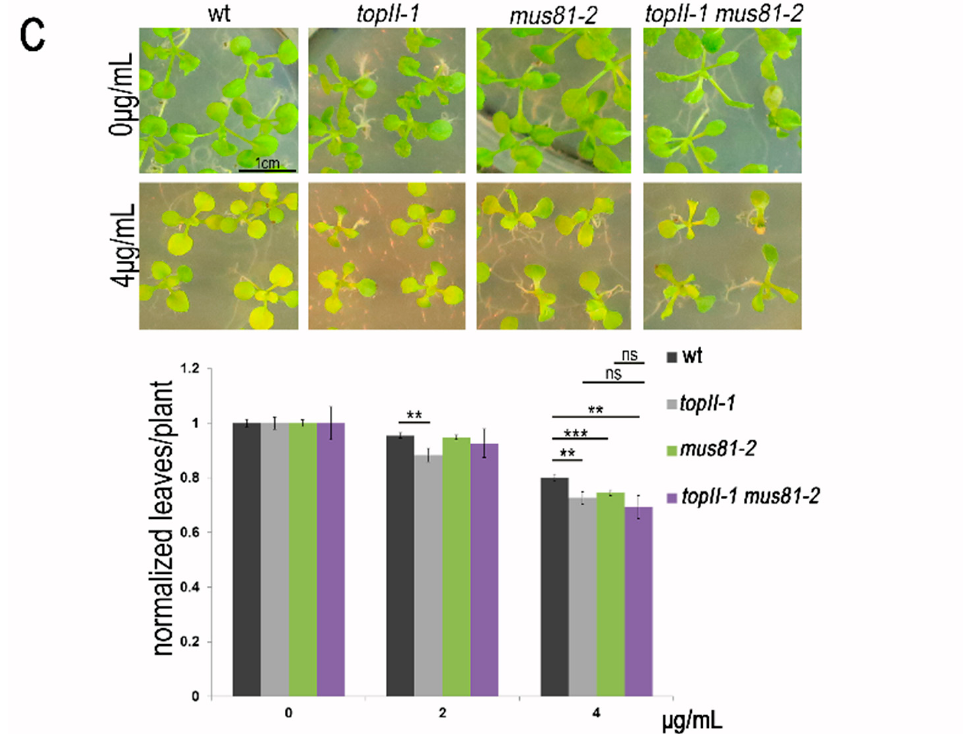
Figure 2. topII-1 is sensitive to DNA damage dependent on mitotic HR. ( A ) Effects of γ irradiation (0, 80, 160 and 300 Gy) on wt and topII-1 somatic seedling development. ( B ) Mitomycin C liquid exposure effects on somatic development on wt and topII-1 plants. ( C ) Mitomycin C exposure effects on somatic development of wt, topII-1, mus81-2 and topII-1 x mus81-2 seedlings. Bars: mean ± standard error of the mean. t -student test p -values: * <0.05, ** <0.01, *** <0.001; ns: not significant.